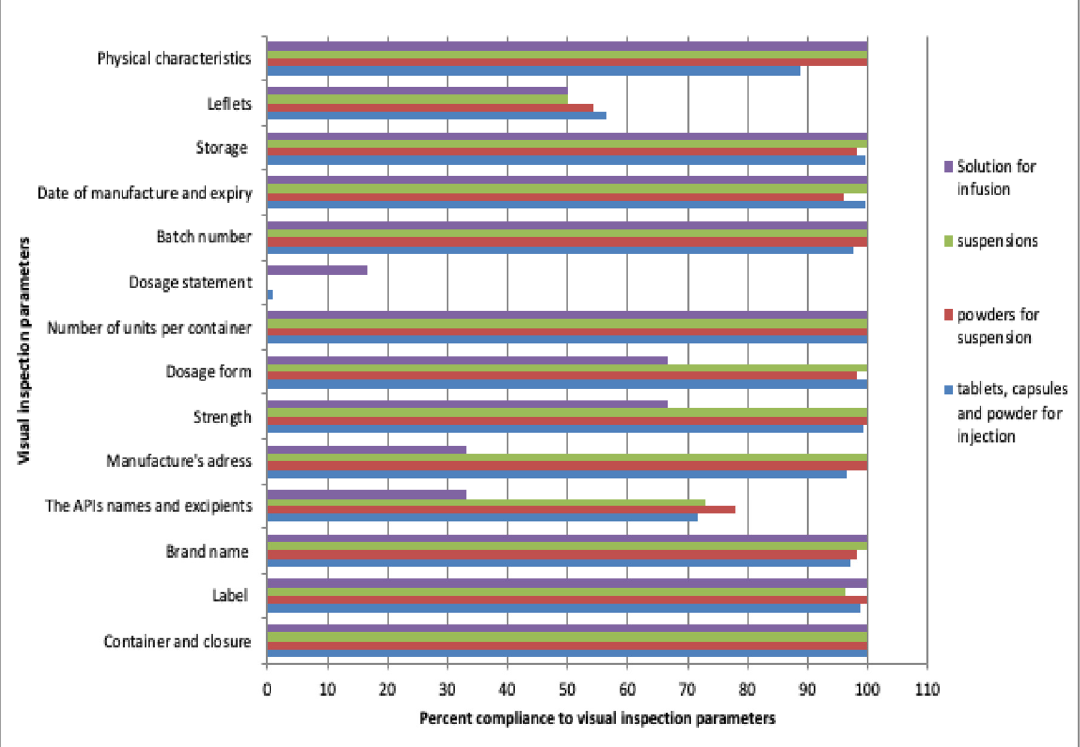
Figure 1. Compliance with visual inspection parameters for all considered pharmaceutical dosage forms: tablets, capsules, powder for injection, powders for oral liquid formulation, oral liquid formulations and infusion.